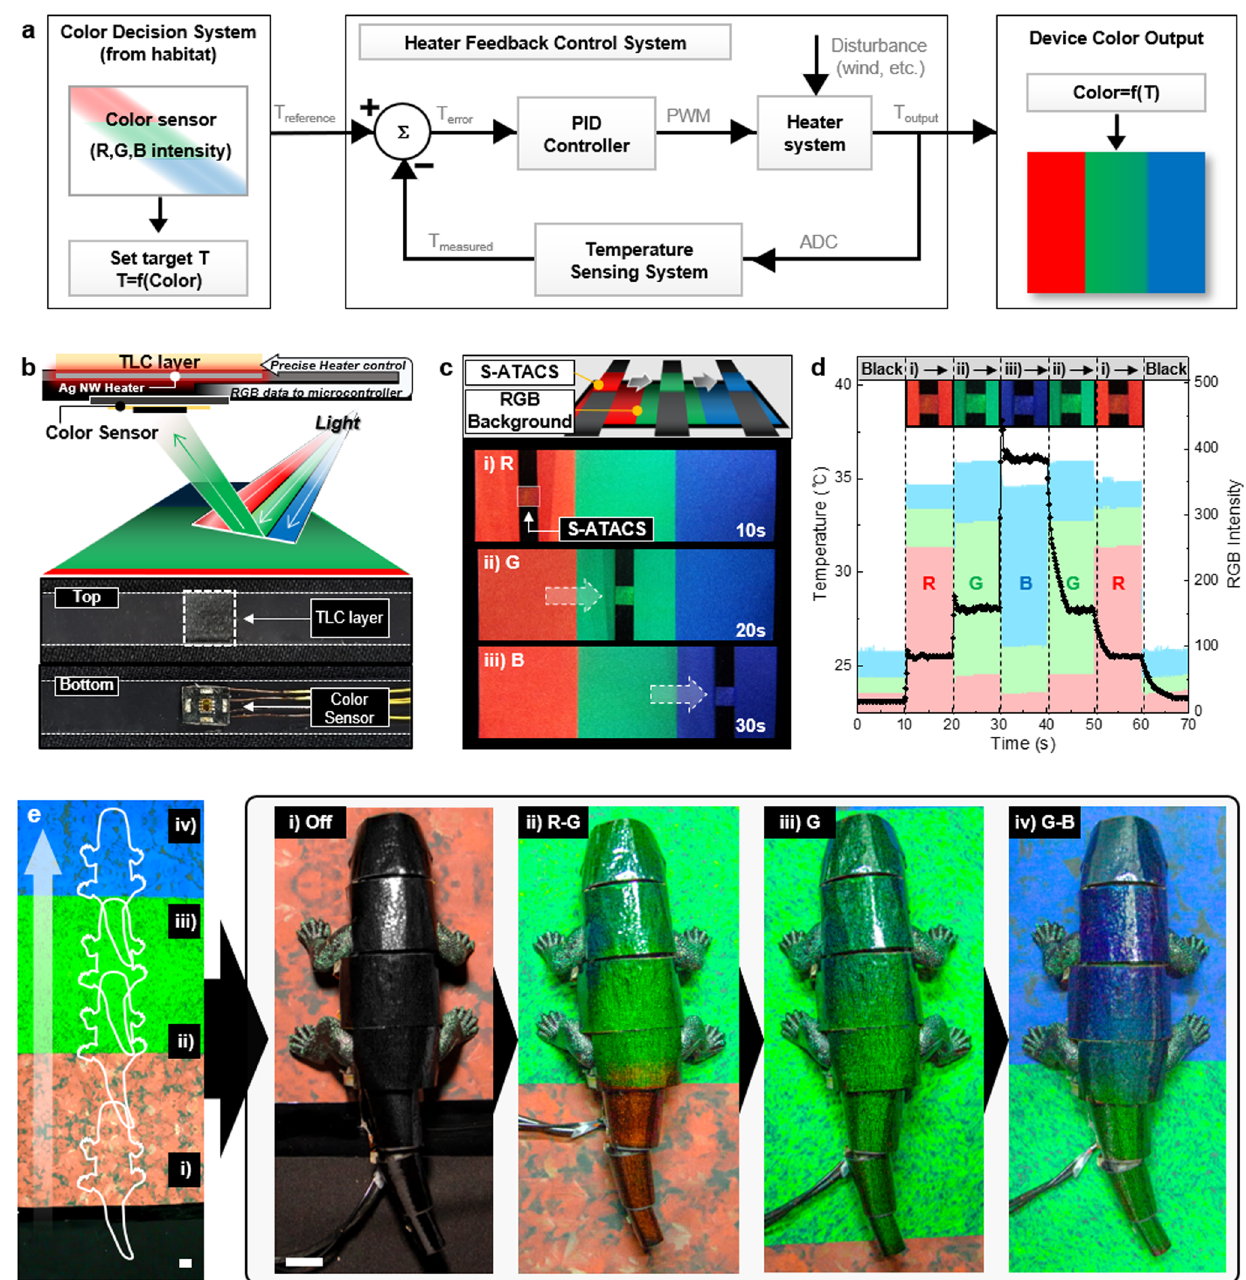
Fig. 4 Demonstration of autonomous S-ATACS with instantaneous crypsis ability. a Schematics of autonomous camou fl age system with heater feedback control logic circuit. b The ATACS with color sensor and its schematics of working principle. c Demonstration of S-ATACS that changes its color using real- time background color data. d The temperature of the ATACS and RGB intensity of real-time color sensing data from the background. Insets are the digital image of S-ATACS color changes with respect to RGB intensity. e Instantaneous crypsis of the chameleon robot. The robot crawls on the background and changes its skin color according to the background color. The scale bar is 3